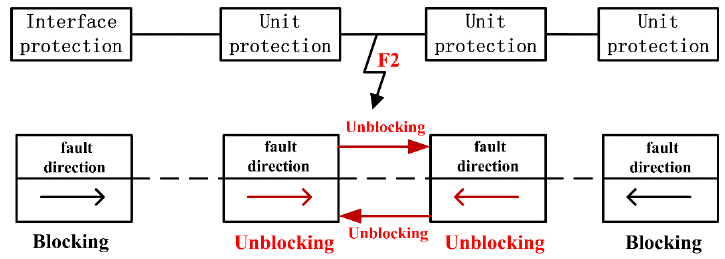
Figure 9. Directional coordination of unit protection.